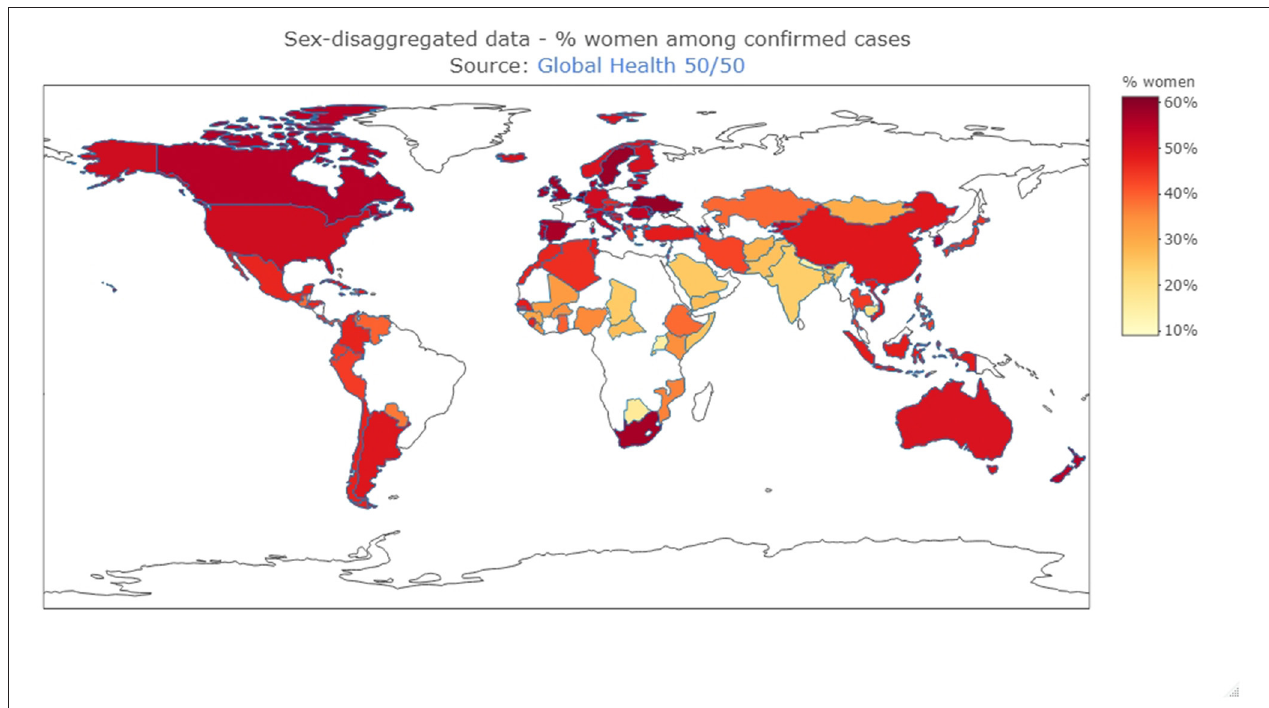
FIGURE 1 | Sex-disaggregated data (Source: Global Health 50/50, https://globalhealth5050.org/covid19/sex-disaggregated-data-tracker/, 15/08/2020) Data are reported from the date that sex-disaggregated data was last available. The map was created using R Statistical Software (version 4.0.2. 2020-06-22, Foundation for Statistical Computing, Vienna, Austria), “plotly”